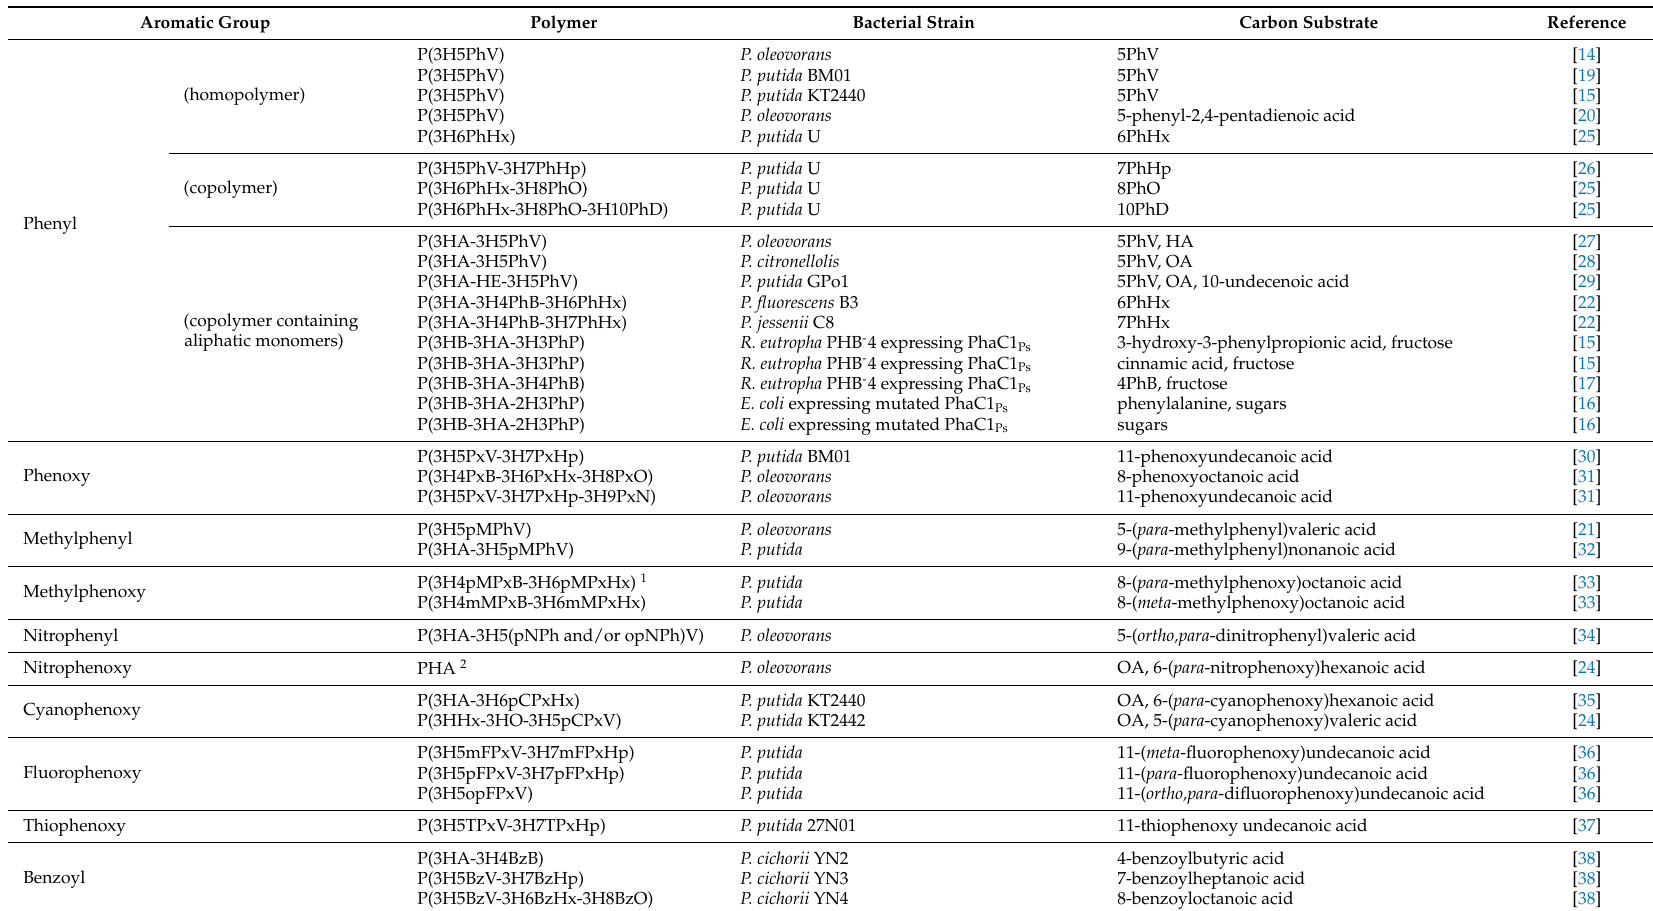
Table 1. Cultivation conditions for production of aromatic polyhydroxyalkanoates